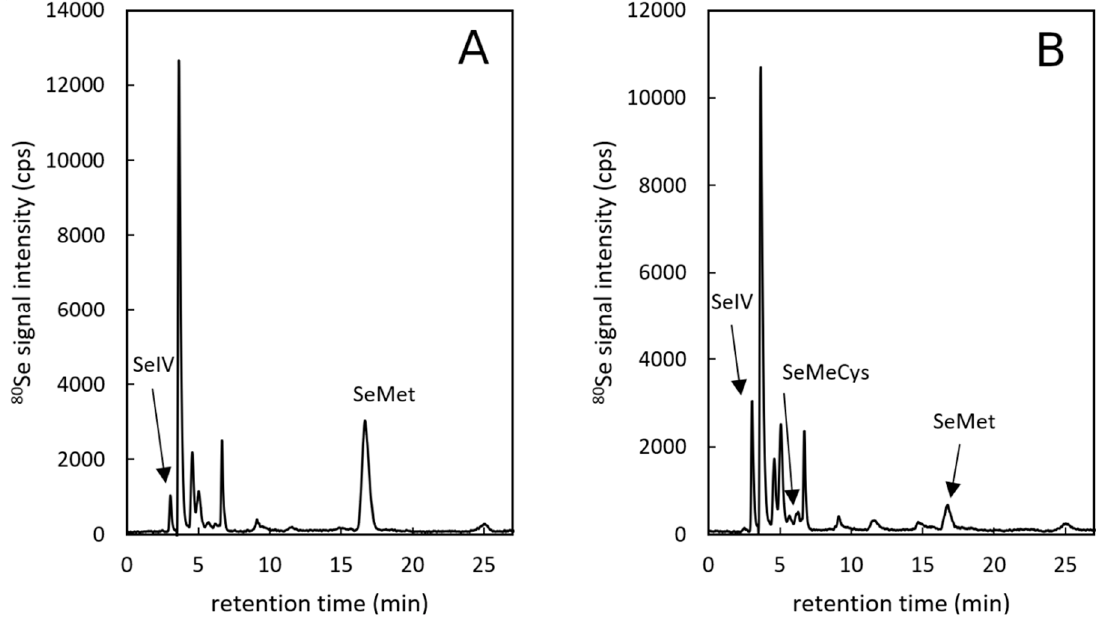
Figure 1. HPLC-inductively coupled plasma (ICP)-MS chromatograms of CCDM 144 (144—5) strain extract ( A ) and CCDM 922A (922—5) strain extract ( B ).